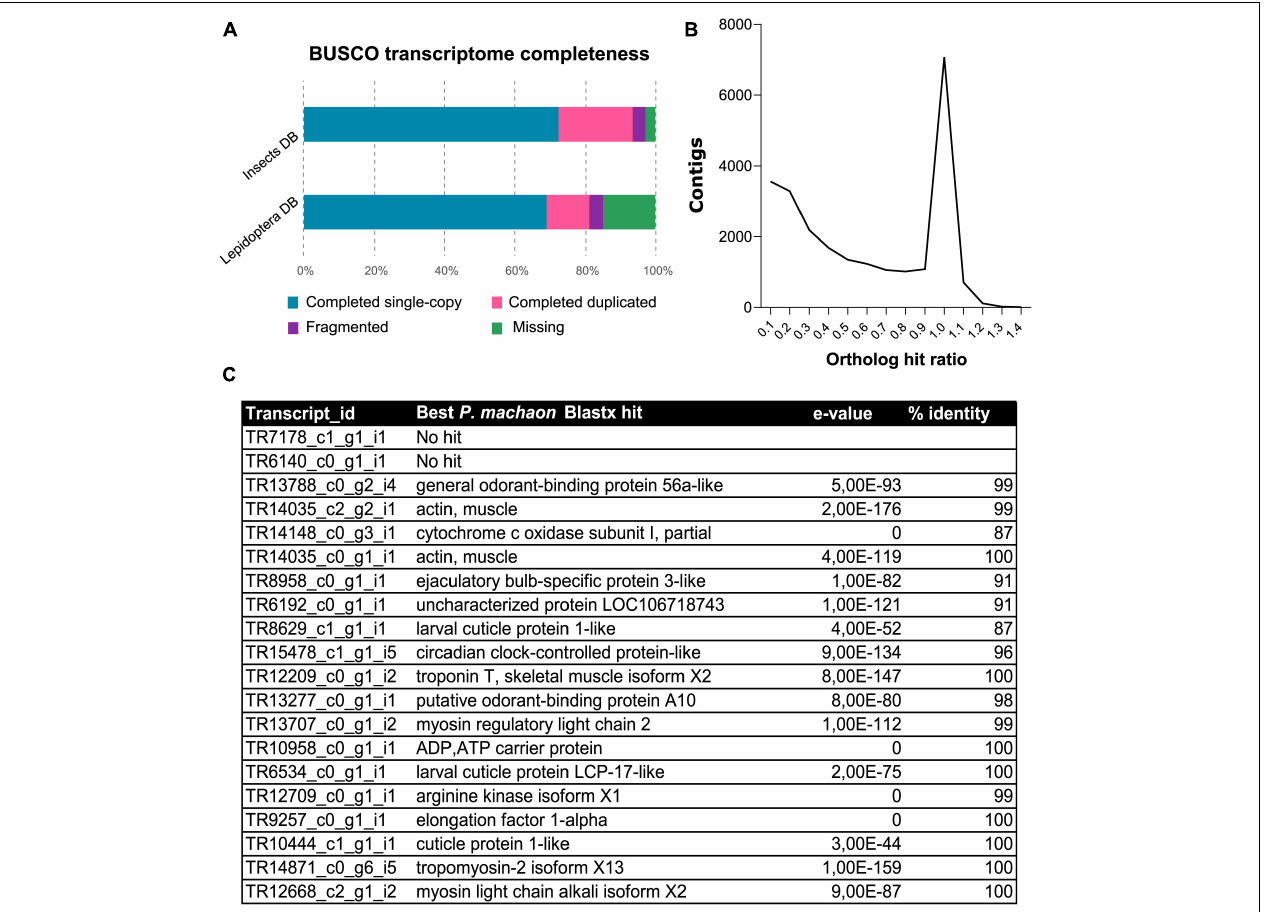
FIGURE 1 | Annotation of de novo assembly from P. hospiton maxilla mRNA. (A) Results from BUSCO analysis against insect and Lepidoptera ortholog databases showing the frequencies of complete single-copy, complete duplicated, fragmented, and missing ortholog from P. hospiton transcriptome (B) ortholog hit ratio (OHR) that estimates contig completeness. OHR was calculated accordingly to O’Neil et al. (2010) using top blastx hit against P. machaon proteome. (C) Top twenty most expressed